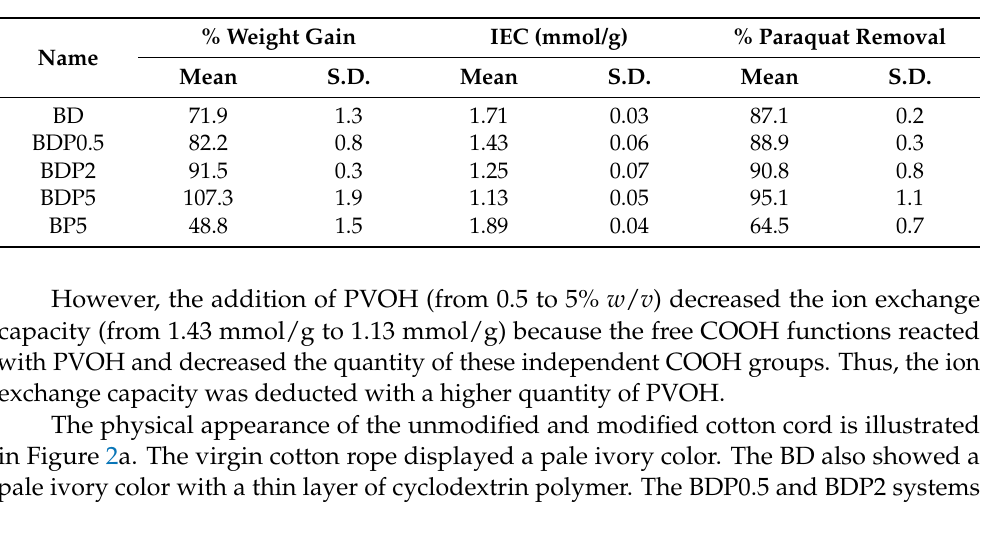
Table 2. Physicochemical properties of cotton cord and their